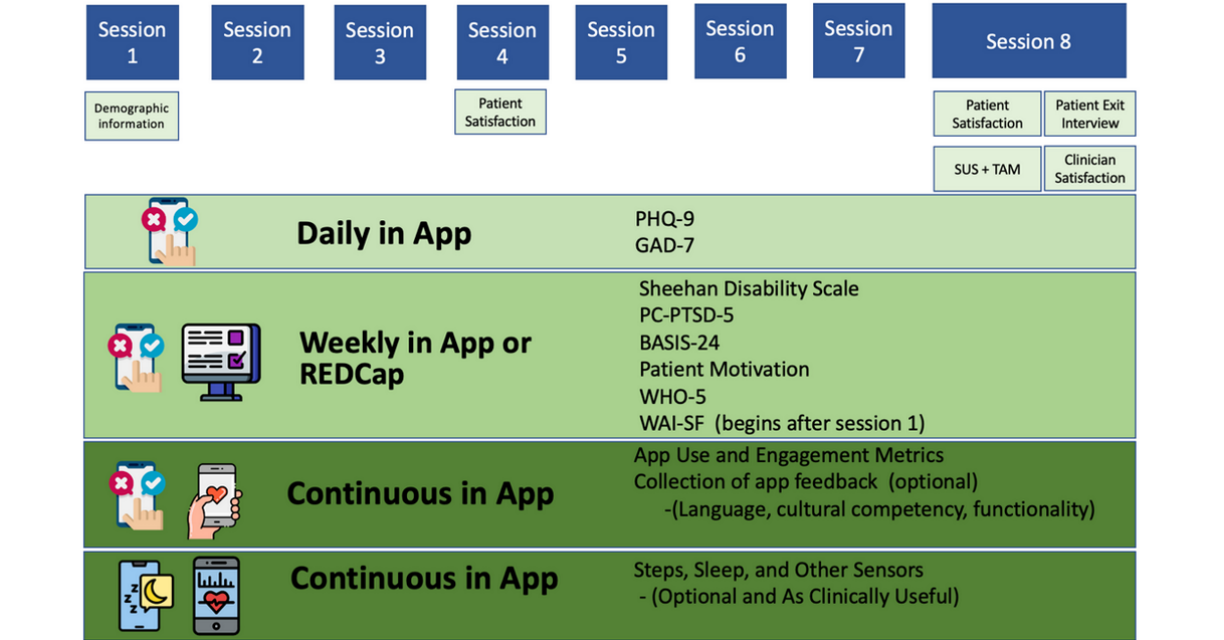
Figure 2. The Technology Enabled Clinical Care survey and data collection timeline. BASIS-24: Behavior and Symptom Identification Scale-24; GAD-7: Generalized Anxiety Disorder-7; PC-PTSD-5: Primary Care Posttraumatic Stress Disorder-5; PHQ-9: Patient Health Question-9; SUS: System Usability Scale; TAM: technology acceptance model; WAI-SF: Working Alliance Inventory–Short Form; WHO-5: World Health Organization